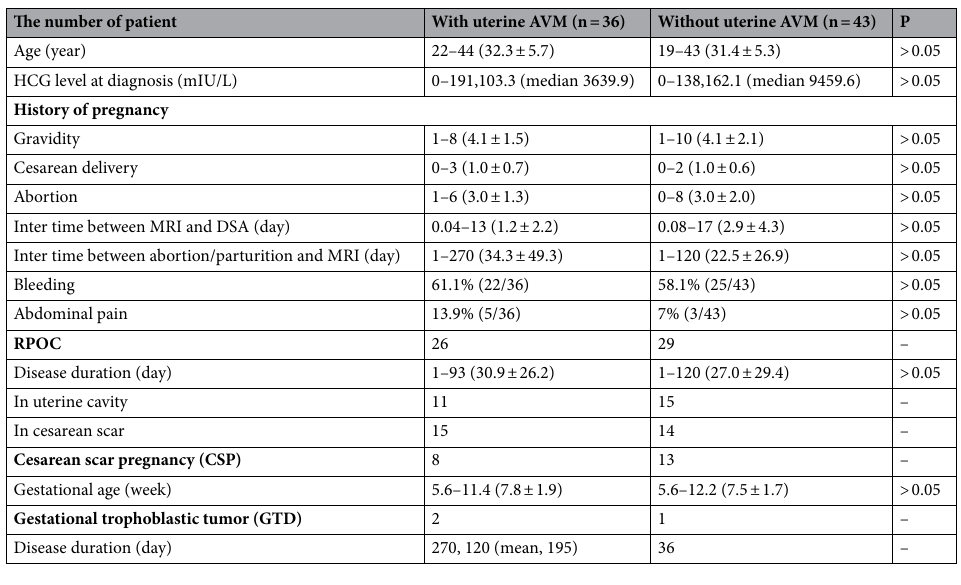
Table 1. Patient characteristics. RPOC retained products of conception, GTD gestational trophoblastic disease, CSP caesarean scar pregnancy, HCG human chorionic